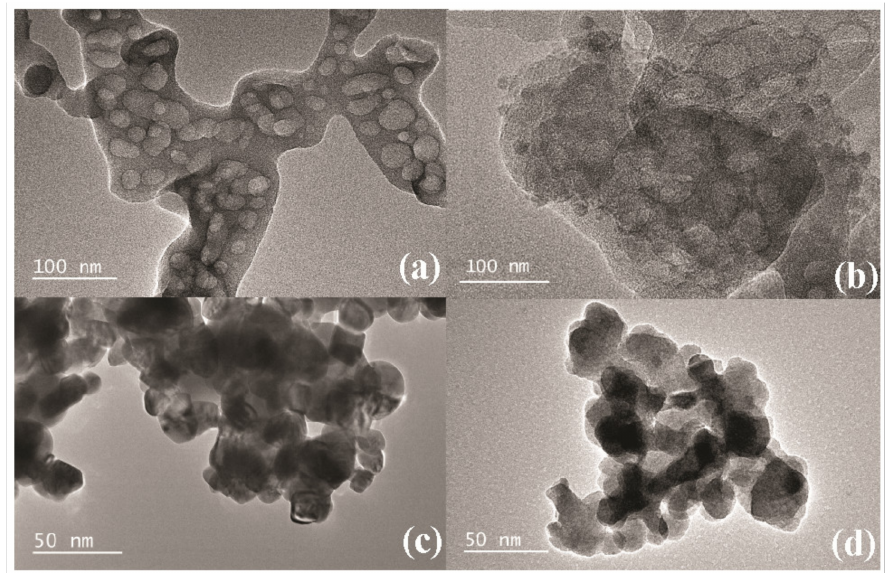
Figure 3. TEM images of synthesized samples: ( a ) bg-C 3 N 4 ; ( b ) hg-C 3 N 4 ; ( c ) 10BiFeO/bg-C 3 N 4 ; and ( d ) 10BiFeO/hg-C 3 N 4